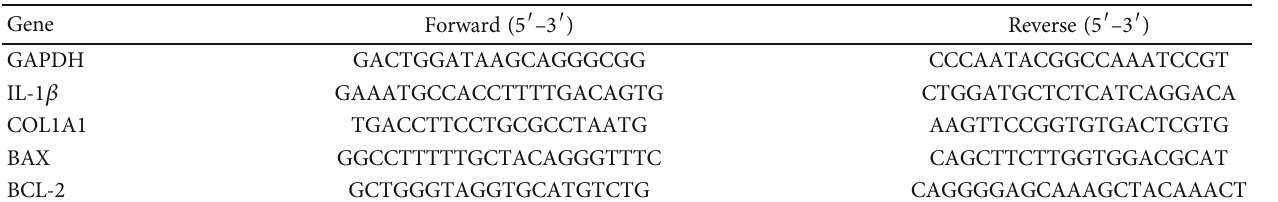
Table 1: Primers for quantitative real-time